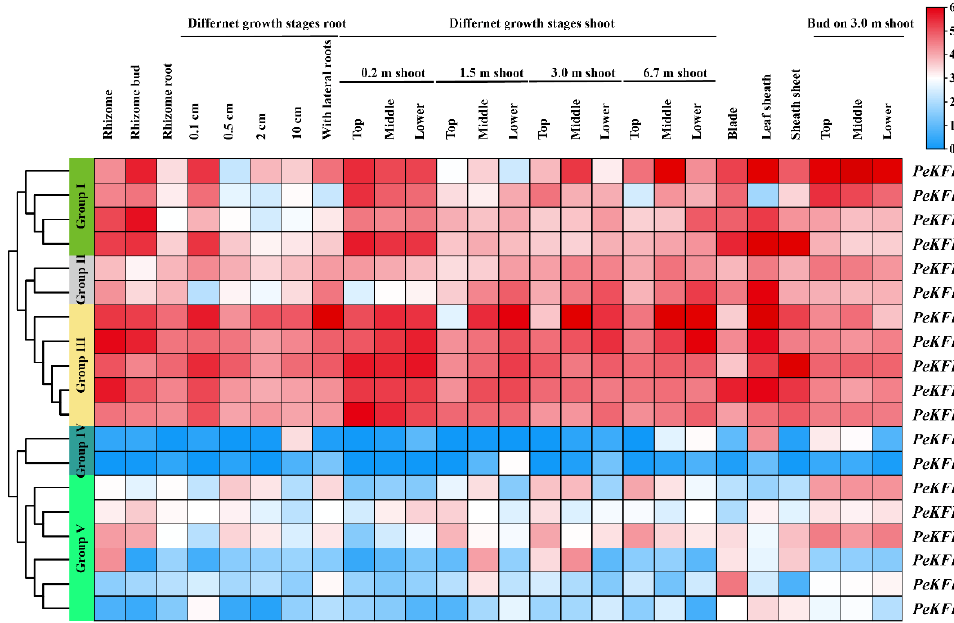
Figure 5. The expression patterns of 19 PeKFB s in different tissues based on RNA-seq data of moso bamboo. Hierarchical clustering heat maps were plotted based on FPKM values of 19 PeKFB s. Five groups are indicated by different colors on the left. The right heatmap shows gene expression with high levels in red and low levels in blue.